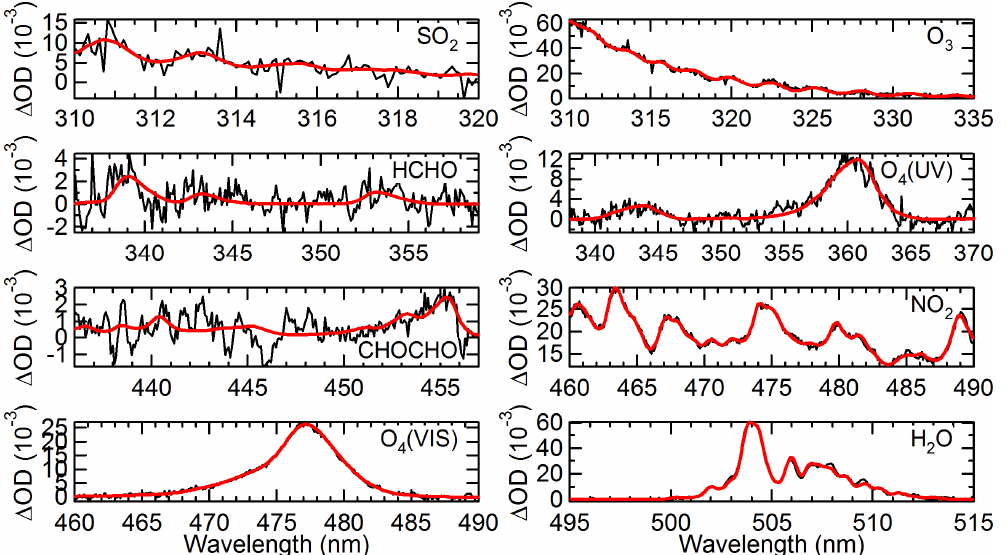
Fig. 1. Examples of fitting results for all species used for the 8-component retrievals (around 11:18 UTC on July 11, 2009; EL=2°). These are cases showing moderate levels of Δ SCDs and fitting residuals for all species at the same time. The red lines show the cross sections scaled to the measured spectra (black) by the DOAS technique. The spectra are plotted as the differential optical density ( Δ OD) from the reference spectrum. Note that different wavelength ranges are used for the 8 panels.